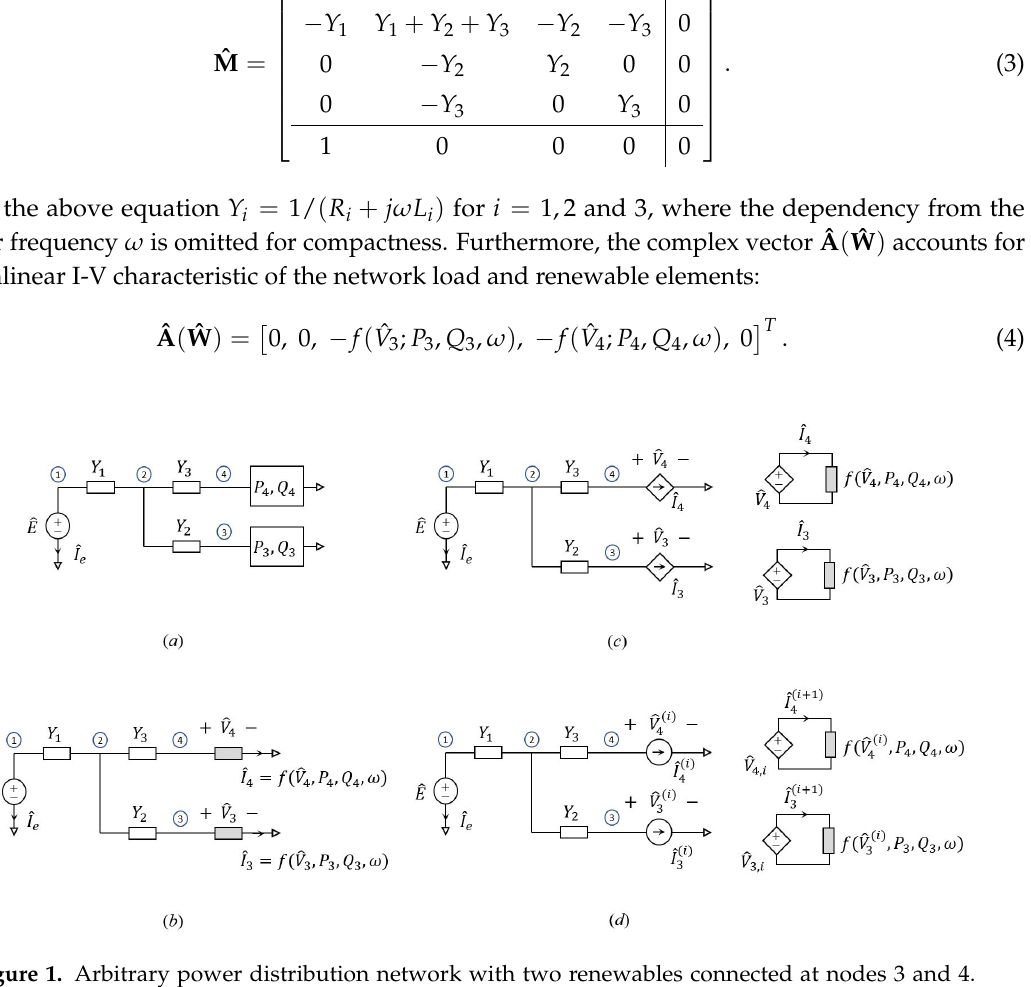
Figure 1. Arbitrary power distribution network with two renewables connected at nodes 3 and 4. ( a ) Original power network; ( b ) interpretation of the network as a nonlinear circuit in the phasor domain. The gray boxes represent two-terminal elements defined by nonlinear current–voltage relations in the phasor domain which are equivalent to the renewables defined by the information on power (see text for details); ( c ) circuit equivalent with controlled circuits, splitting the original network into two parts, a large linear portion and a nonlinear section defined by the nonlinear elements only; ( d ) circuital interpretation of the proposed iterative solution